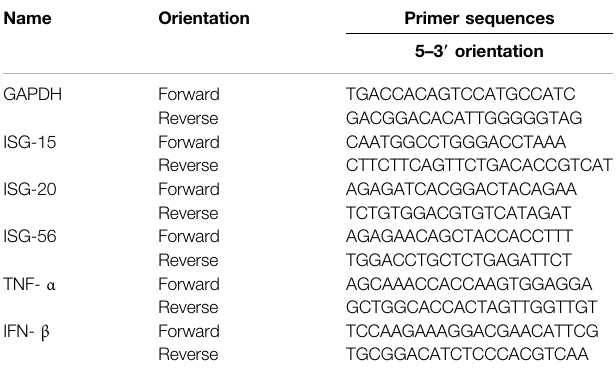
TABLE 1 | Primers sequences for real-time